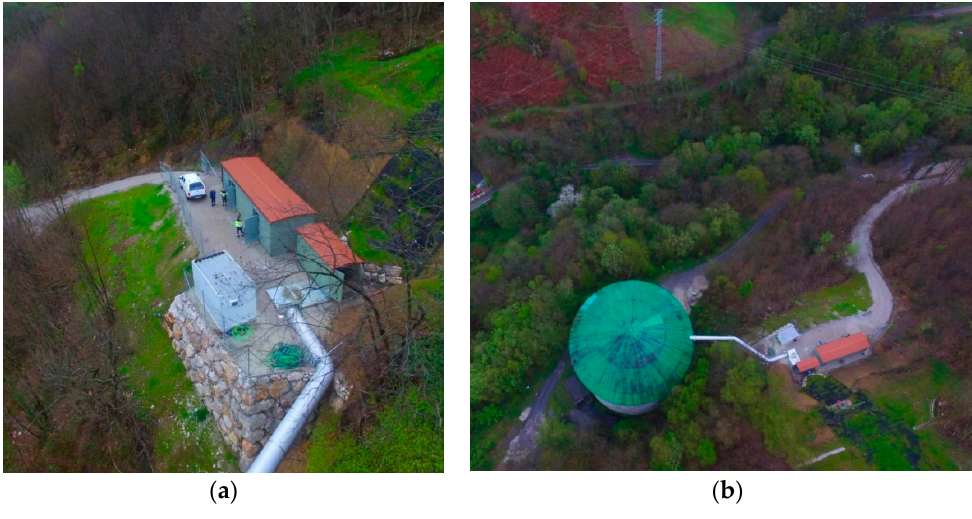
Figure 5. Aerial View: ( a ) Turbine module and electrical building; ( b ) The device and the final